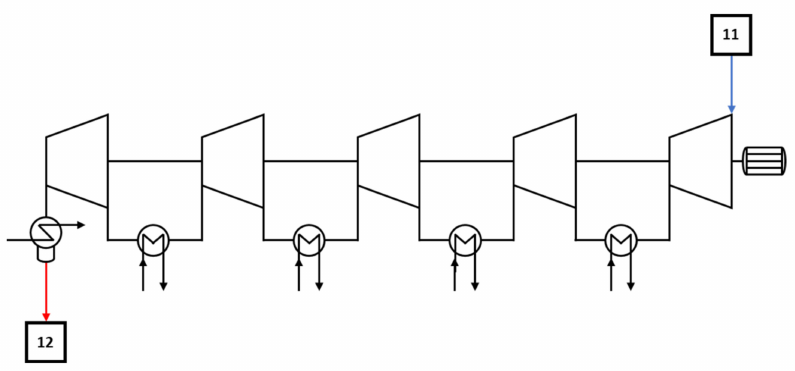
Figure 5. Underground storage block scheme (line 11 is the inlet pure CO 2 gas stream, line 12 is the pressurized and liquefied CO 2